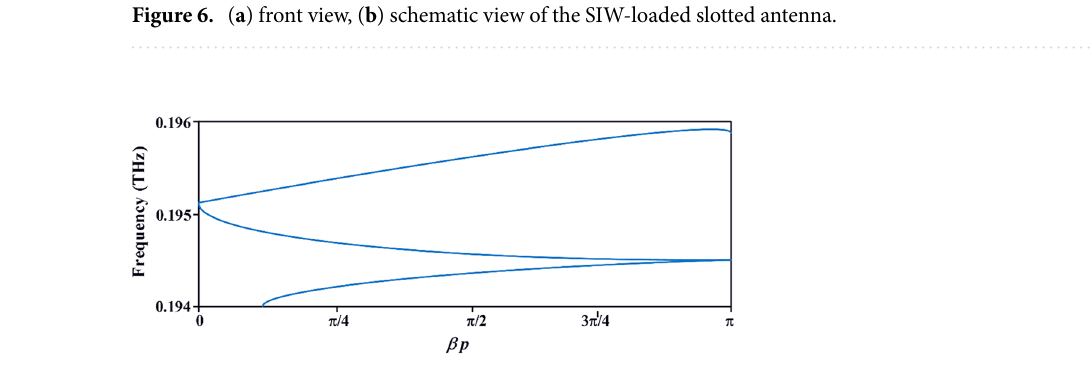
Figure 7. Dispersion diagram of the SIW-loaded slotted antenna.